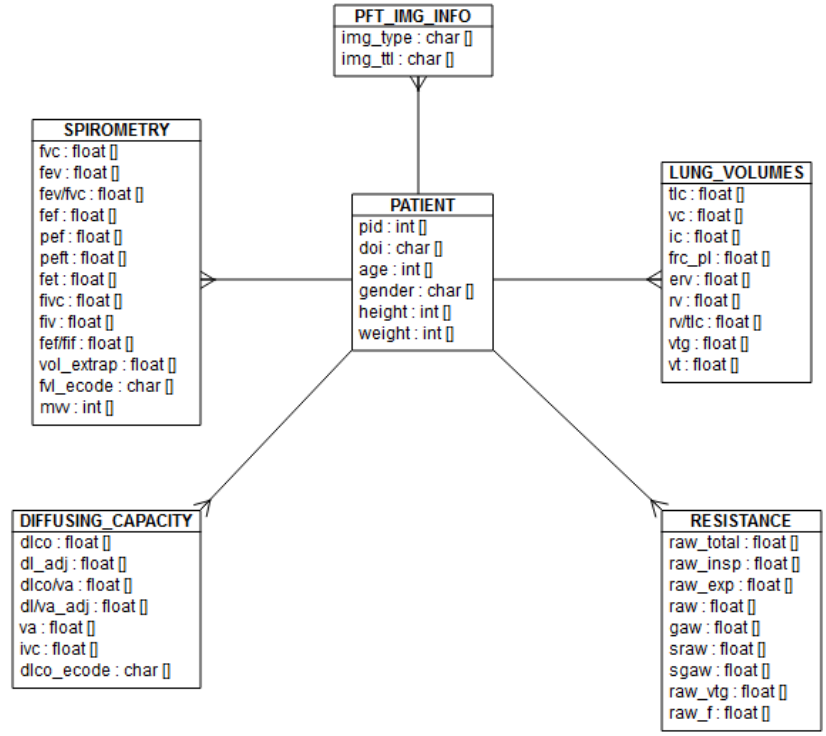
Figure 5. Entity relationship diagram (ERD) of the CIMI database architecture.